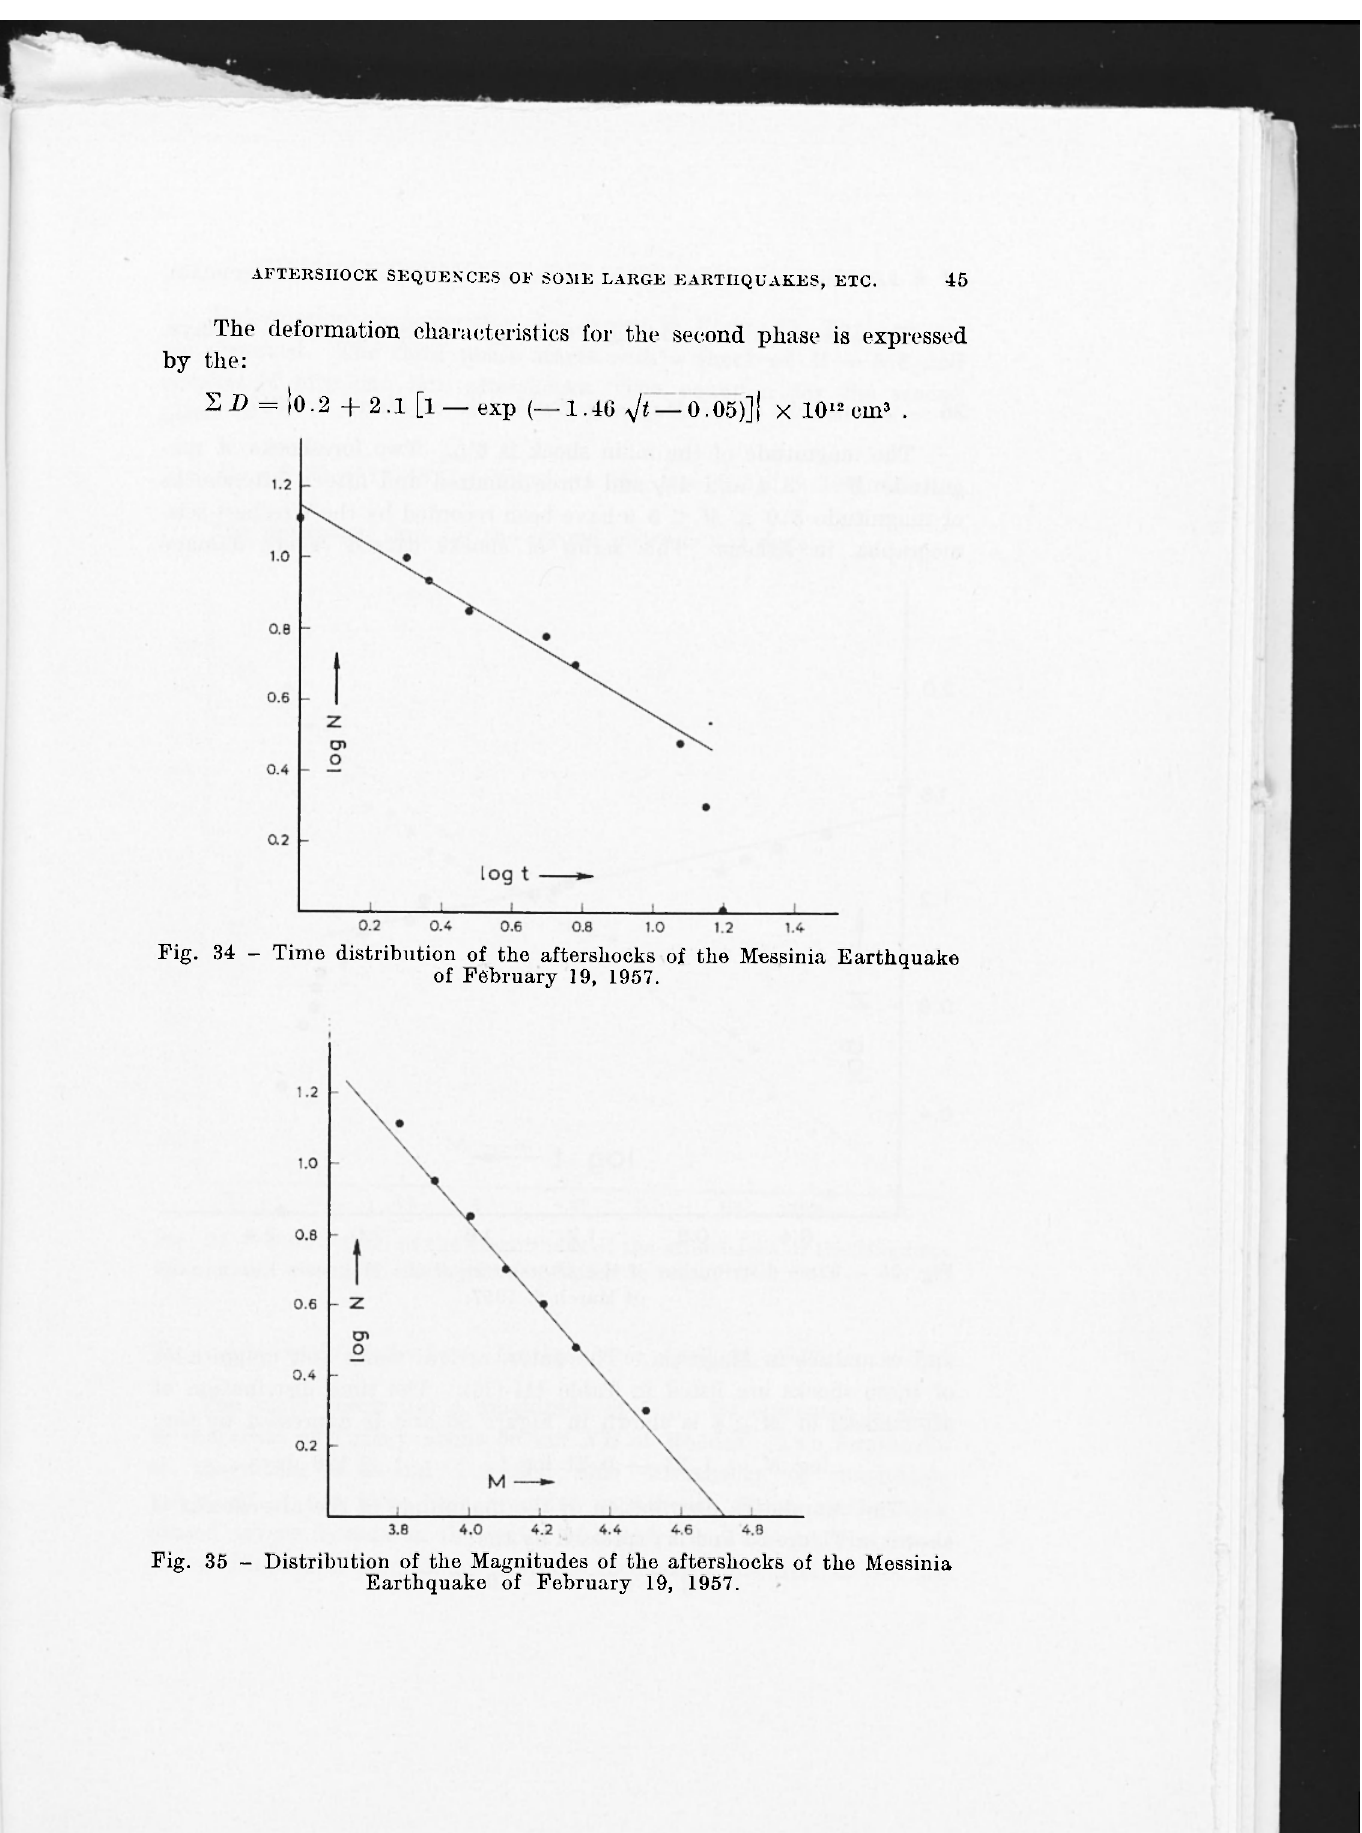
Fig. 35 - Distribution of the Magnitudes of the aftershocks of the Messinia Earthquake of February 19,